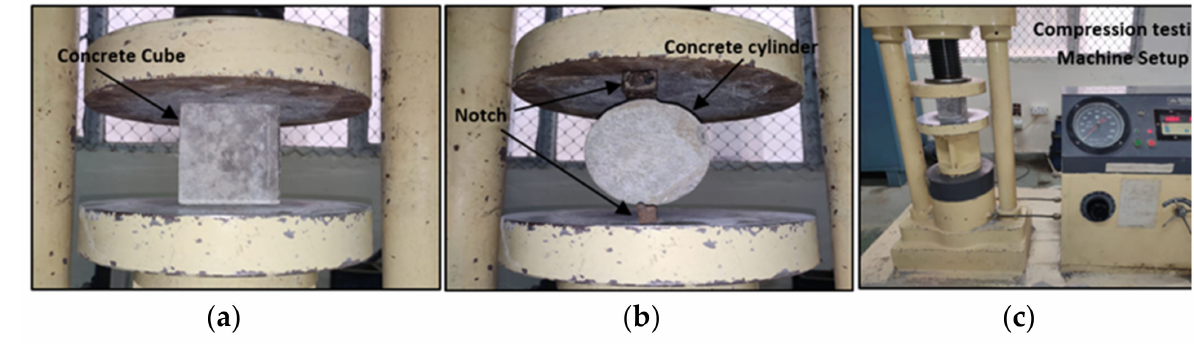
Figure 3. Mechanical strength test setup. ( a ) Compressive Strength test on Cube. ( b ) Split Tensile Strength test on cylinder. ( c ) Compression testing machine.